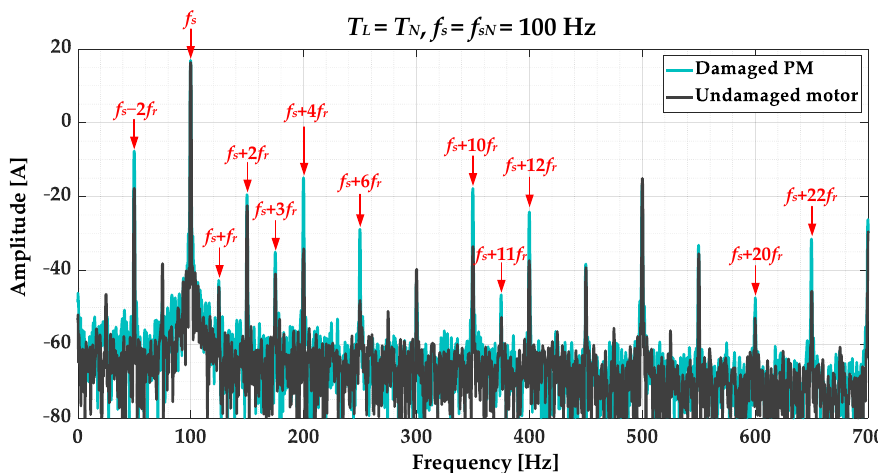
Figure 4. Comparison of the FFT spectra of the stator phase current in phase A for undamaged motor and rotor with damaged PM (partial demagnetization), experimental study ( T L = T N , f s = f sN = 100 Hz).